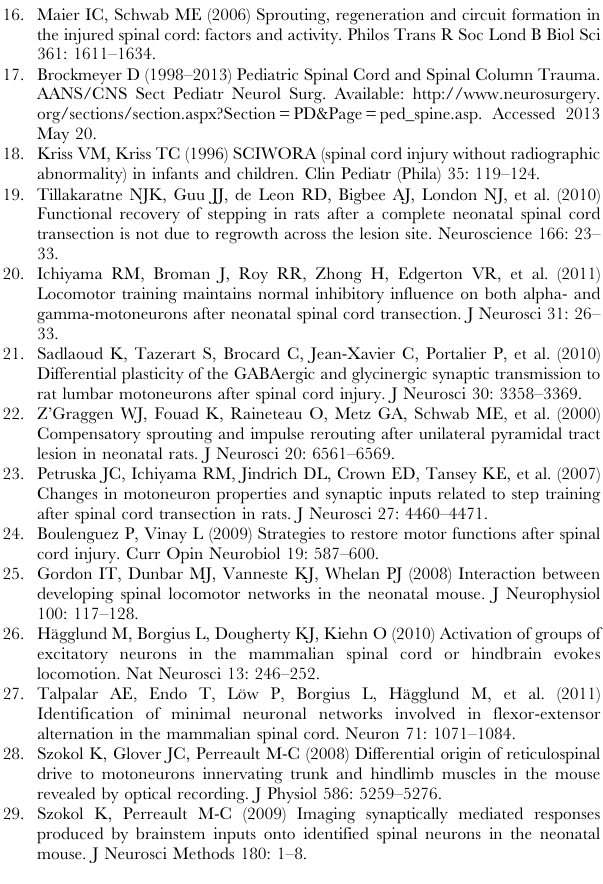
stance durations of the 4 paws of SCC and sham mice during single track locomotion. (TIF) Figure S3 Electrophysiological activity in descending motor pathways 8 days after surgery/injury. (A) Activity pattern in lumbar ventral roots in response to electrical ventral funiculus (VF) train stimulation (25 pulses during 5 s, pulse duration 0.2 ms, x2T–x3T, where T =threshold for generating a response) in one sham control mouse (top black trace) and one SCC mouse (bottom red trace). Bottom plots in A show the instantaneous firing frequency. (B) Activity pattern in lumbar ventral roots in response to electrical single pulse stimulation of the ipsilateral ventral funiculus (ipsi VF, top pair of traces) and ipsilateral dorsal root in the same segment (ipsi DR, bottom pair of traces) in one sham control mouse (black traces) and one SCC mouse (red traces).